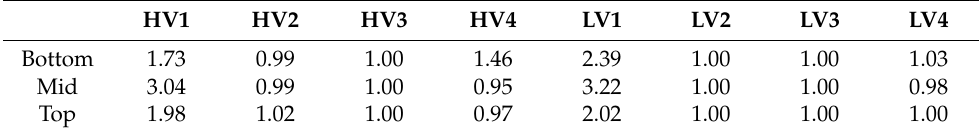
Table 5. The change multiples of radial peak resultant forces of windings.